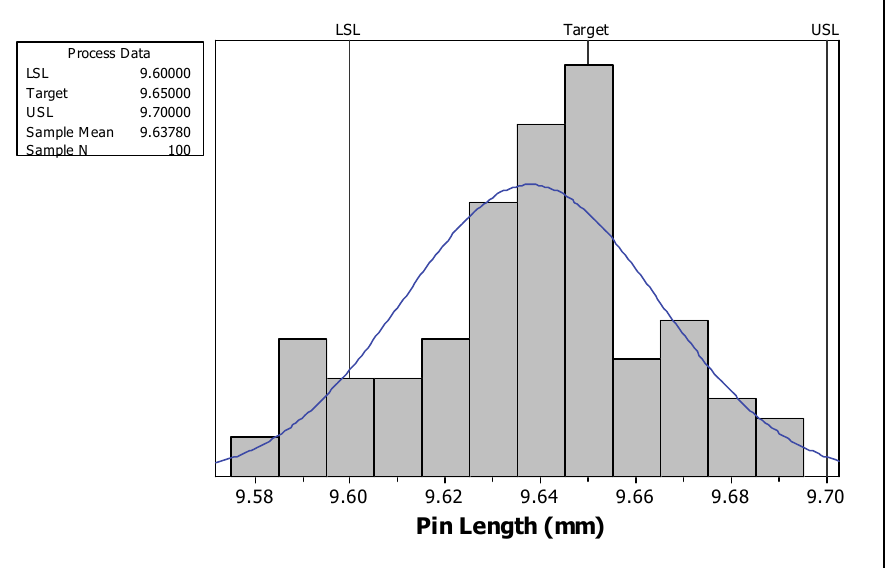
Fig. 3. Histogram for Pin Length before Implementing DMAIC